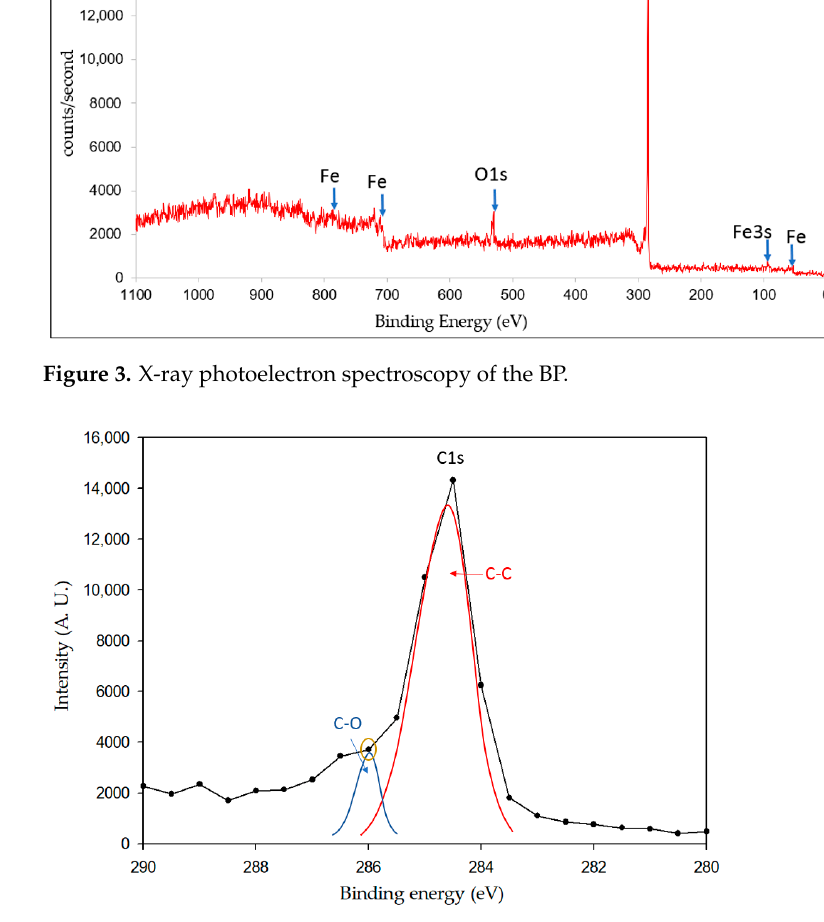
Figure 4. Simple deconvolution of the carbon spectra from Figure 3.